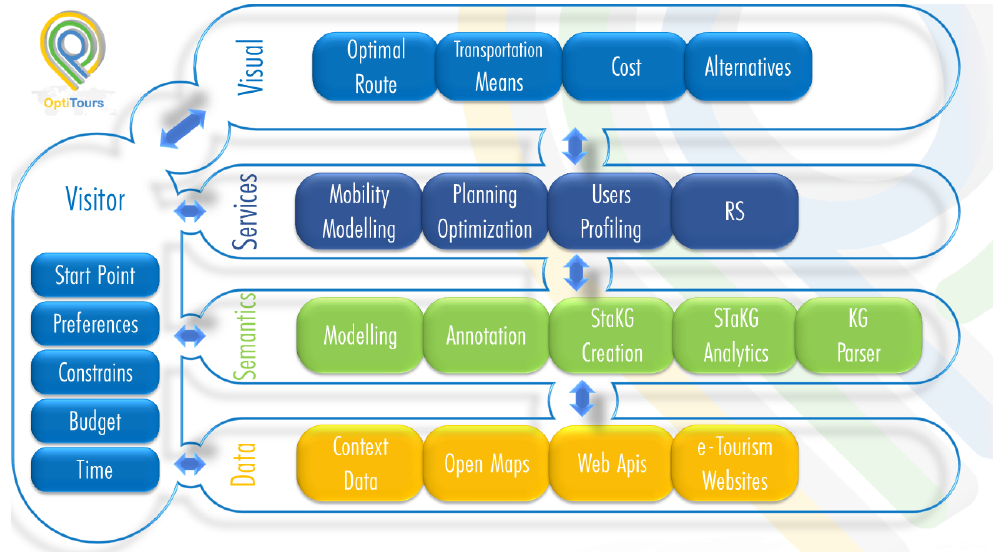
Figure 1. OptiTours proposed conceptual